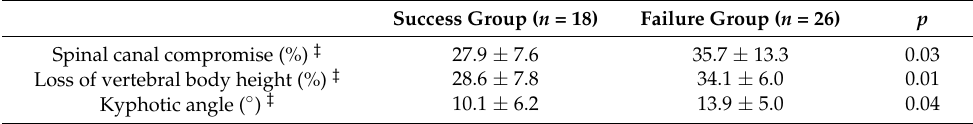
Table 4. Preoperative radiological